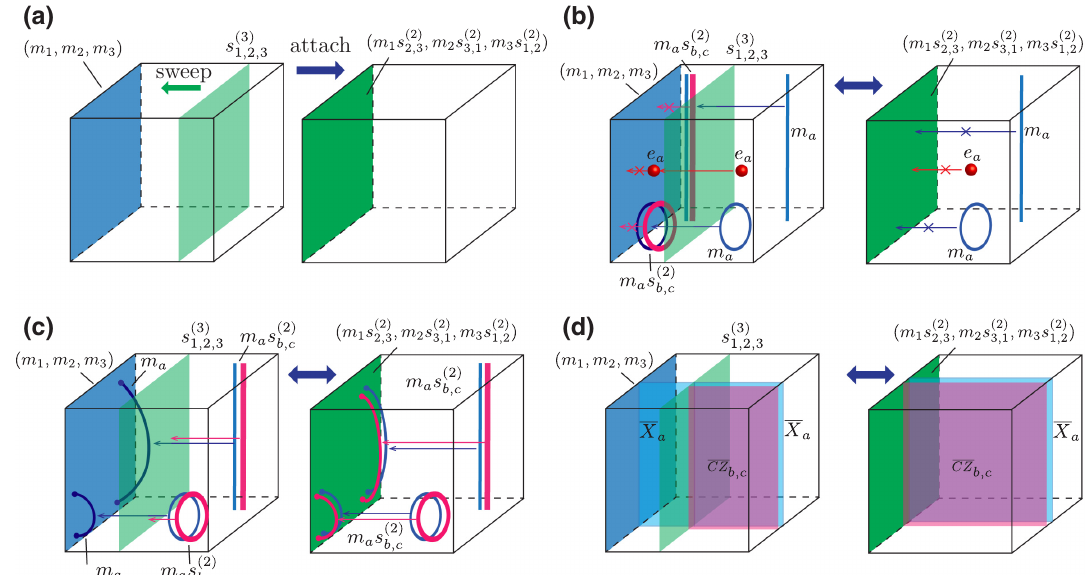
FIG. 28. (a) The application of a transversal CCZ effectively sweeps the domain wall s ( 3 ) across the system and attaches it to the 1,2,3 ( 2 ) ( m ) -boundary without being condensed, generating an exotic ( m ) -boundary (green). (b) The e -particle and , m 2 s ( 2 ) , m 3 s ( 2 ) 1 , m 2 , m 3 1 s 2,3 3,1 1,2 ) -boundary (shown on the right), which can be considered as a compos- , m 2 s ( 2 ) , m 3 s ( 2 ) m -string alone cannot condense on the ( m 1 s ( 2 ) 2,3 3,1 1,2 -wall and the ( m 1 , m 2 , m 3 ) -boundary (shown on the left). The e a -particle and m a -string get transformed into e a and ite of the s ( 3 ) 1,2,3 when passing the domain wall first and hence cannot condense on the remaining ( m 1 , m 2 , m 3 ) -boundary. (c) The m a s ( 2 ) m a s 2 b , c ) -boundary, since it gets transformed to an m , m 2 s ( 2 ) , m 3 s ( 2 ) can condense on the exotic ( m 1 s ( 2 ) a -string when passing the S 2,3 3,1 1,2 and can then condense on the remaining ( m 1 , m 2 , m 3 ) -boundary. (d) The product of logical branes X a CZ b , c can terminate on the ( 2 ) ( m ) -boundary, since it gets transformed to X 3 , m 2 s ( 2 ) , m 3 s ( 2 ) -wall and then terminates on the remaining 1 s a when passing the S 1,2,3 2,3 3,1 1,2 ) -boundary. ( m 1 , m 2 , m 3